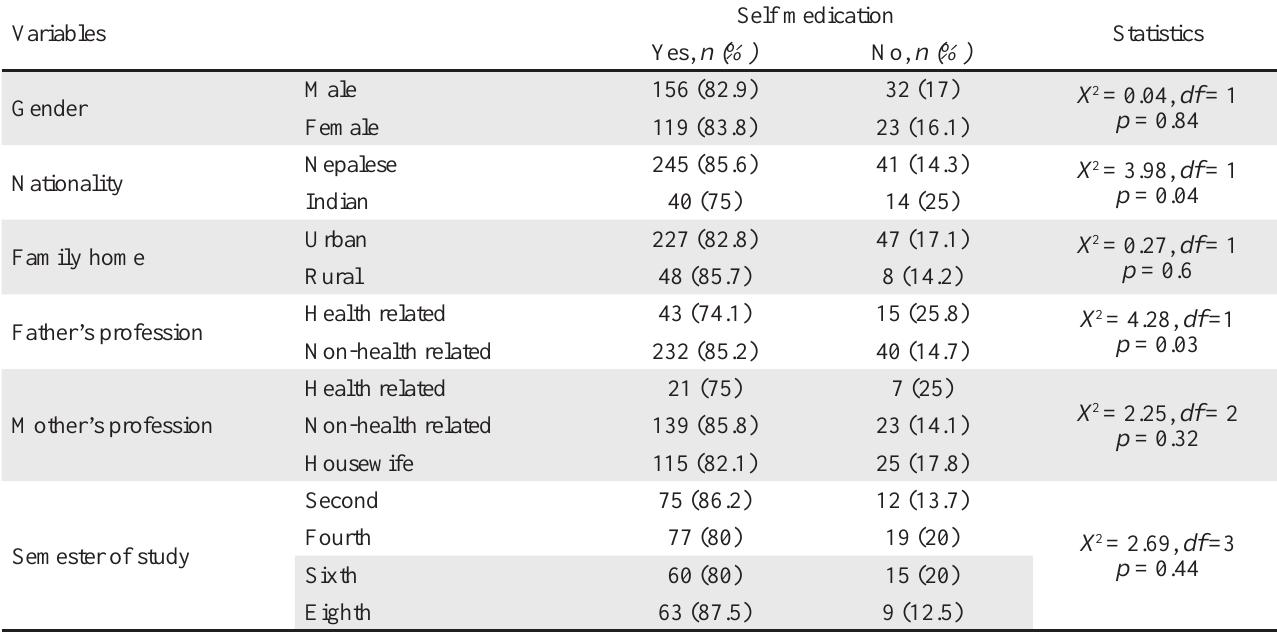
Table 3 : Prevalence of self-medication practice based on demographic profile (N = 330) Variables